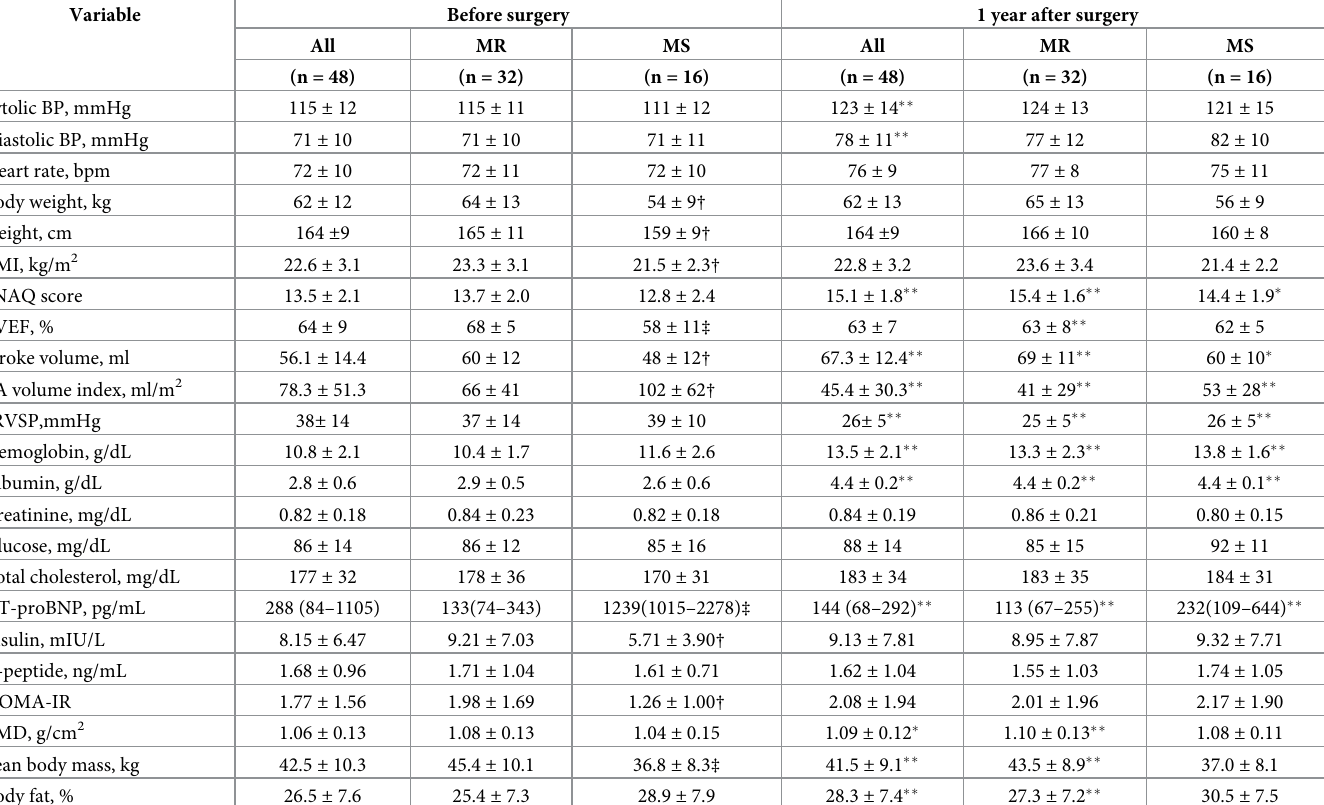
Table 1. Changes in anthropometric, echocardiographic, laboratory measurements and body composition before and after mitral valvular surgery according to the primary valve lesion. Variable Before surgery